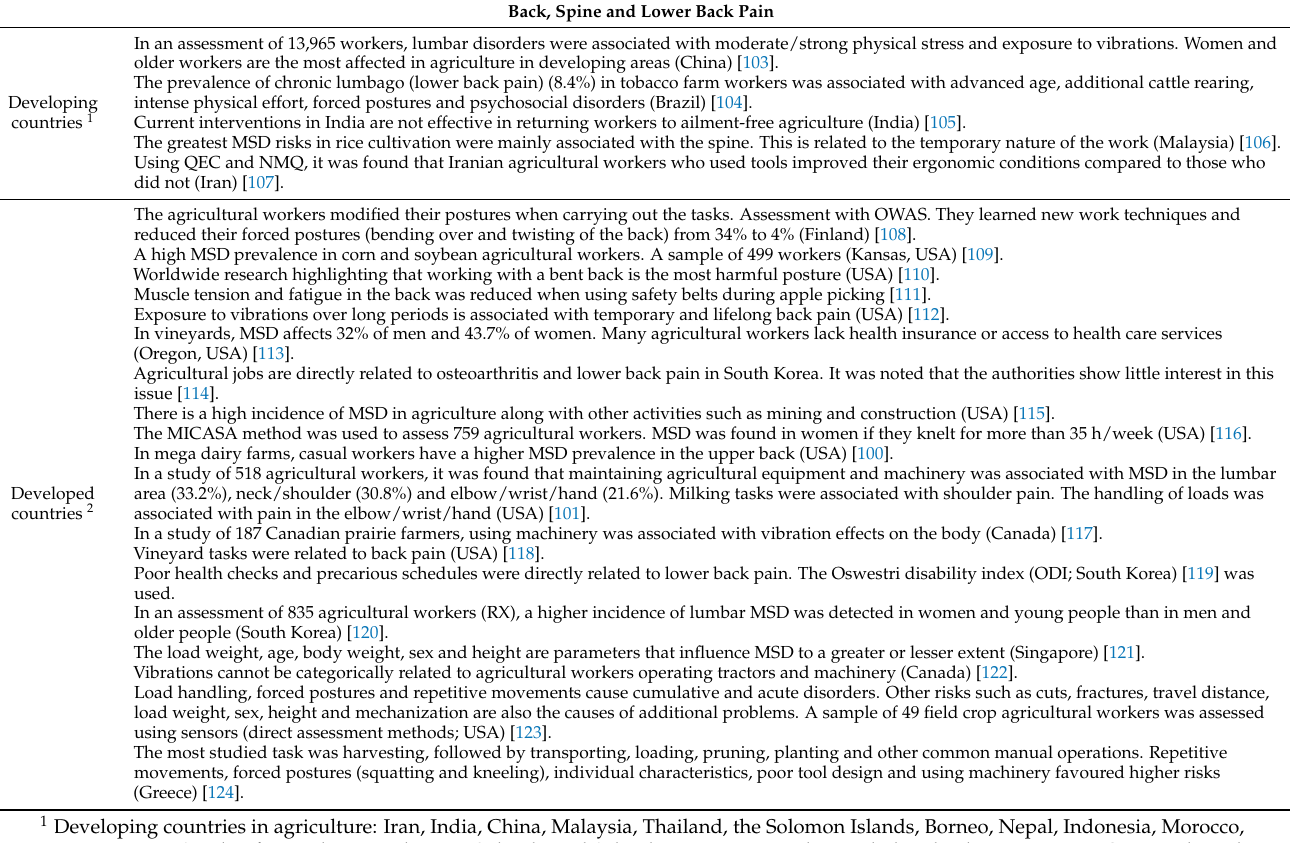
Table A3. MSD research in agriculture (1995–2020). Category: Back, spine and lower back pain. Back, Spine and Lower Back Pain